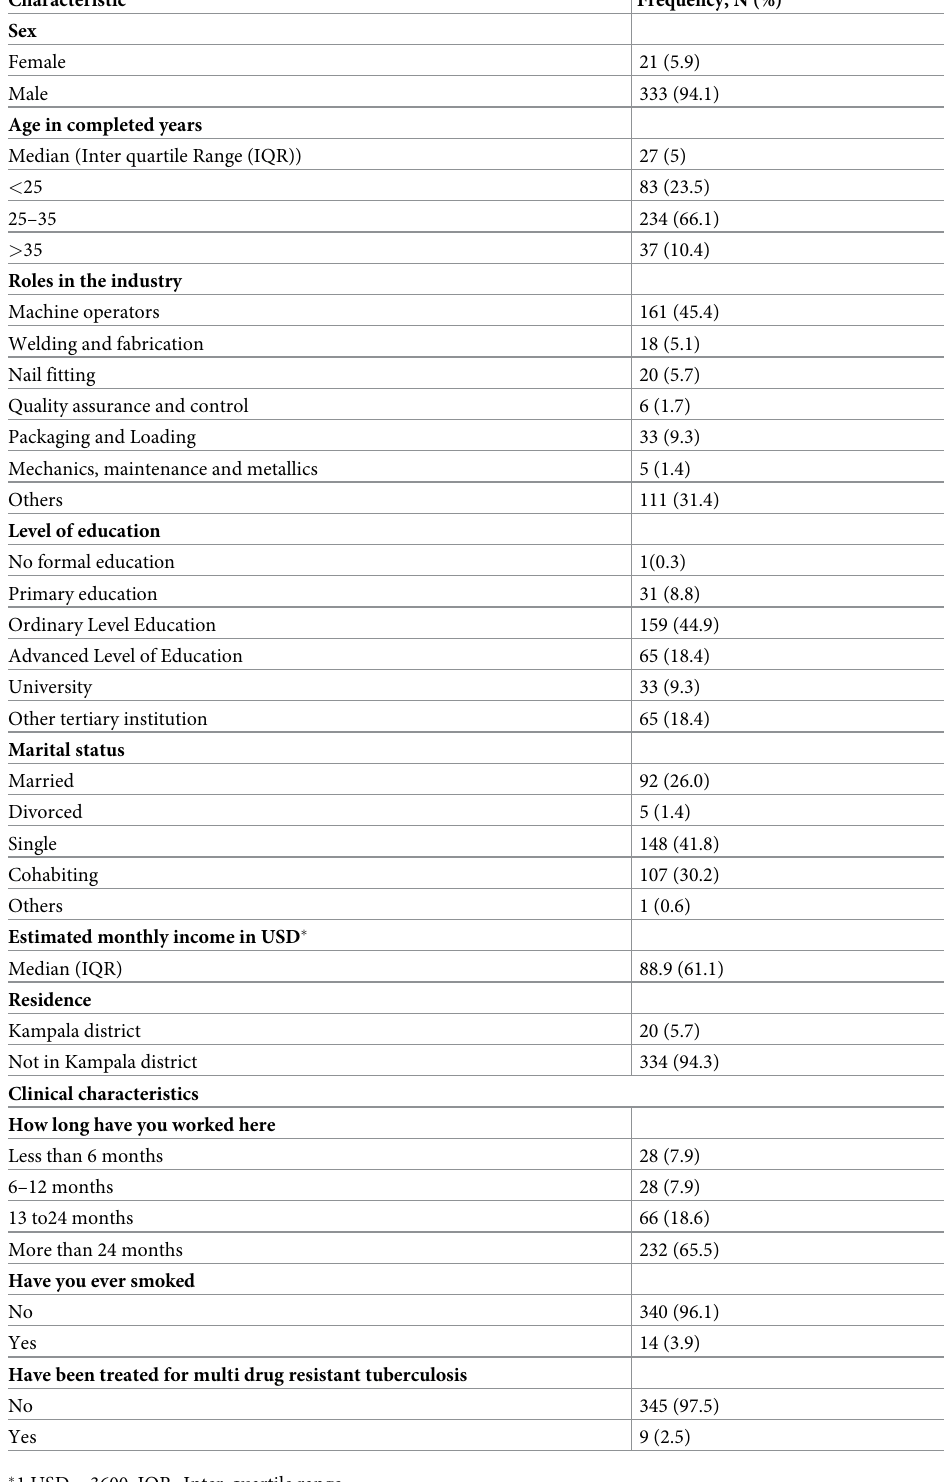
Table 1. Socio-demographic and clinical characteristics of the study